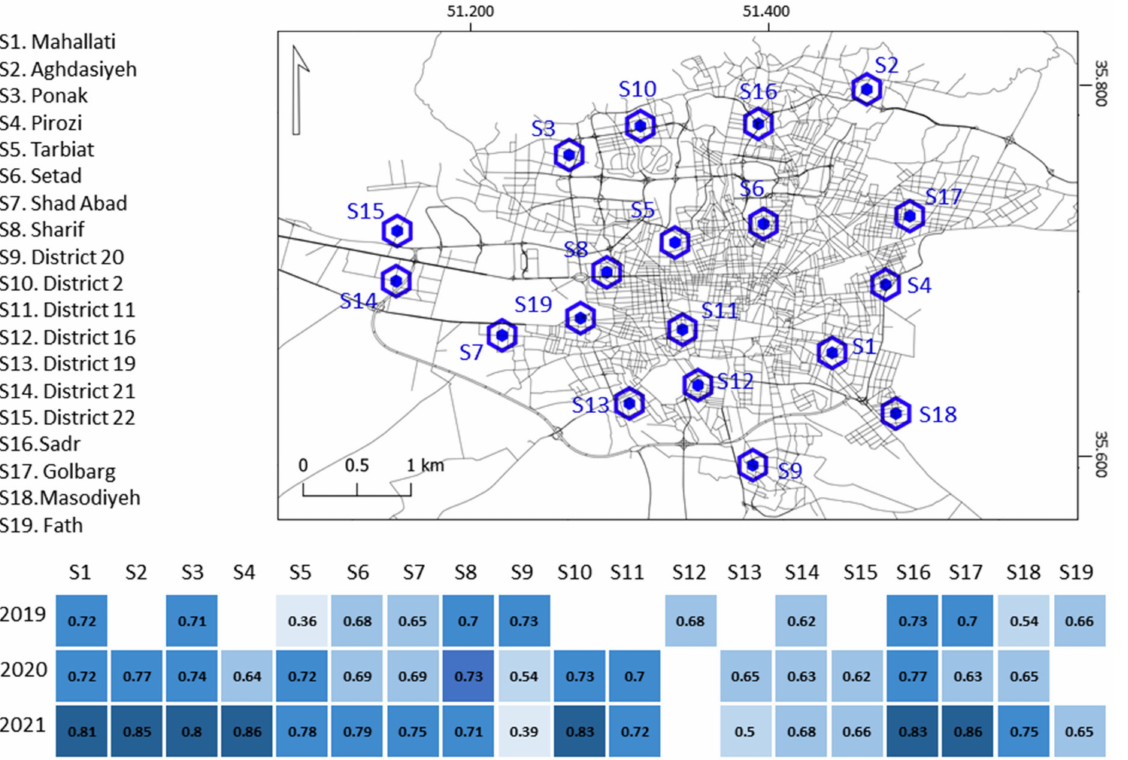
Figure 9. The location of the NO 2 ground stations in Tehran and the correlation coefficients obtained by comparing their in situ measurements with those of the